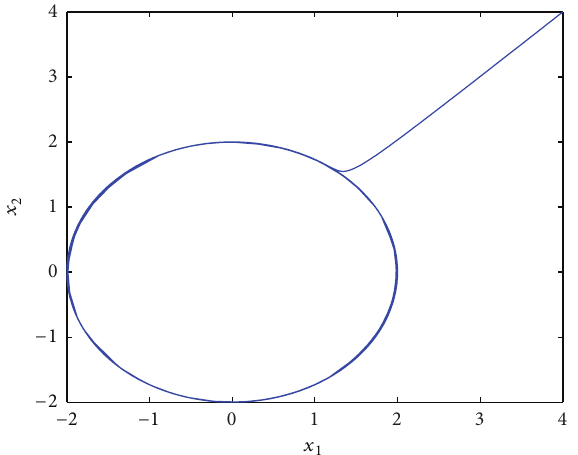
Figure 3: Typical phase trajectories of the nonlinear system (1a) and (1b), with 𝑎 = 𝑐 2 = 𝑘 = 𝑖 = 1, 𝑐 1 = 2, 𝑟 = 4, 𝑑 = 0.1, [𝑥 10 𝑥 20 ] 𝑇 = [4 4] 𝑇